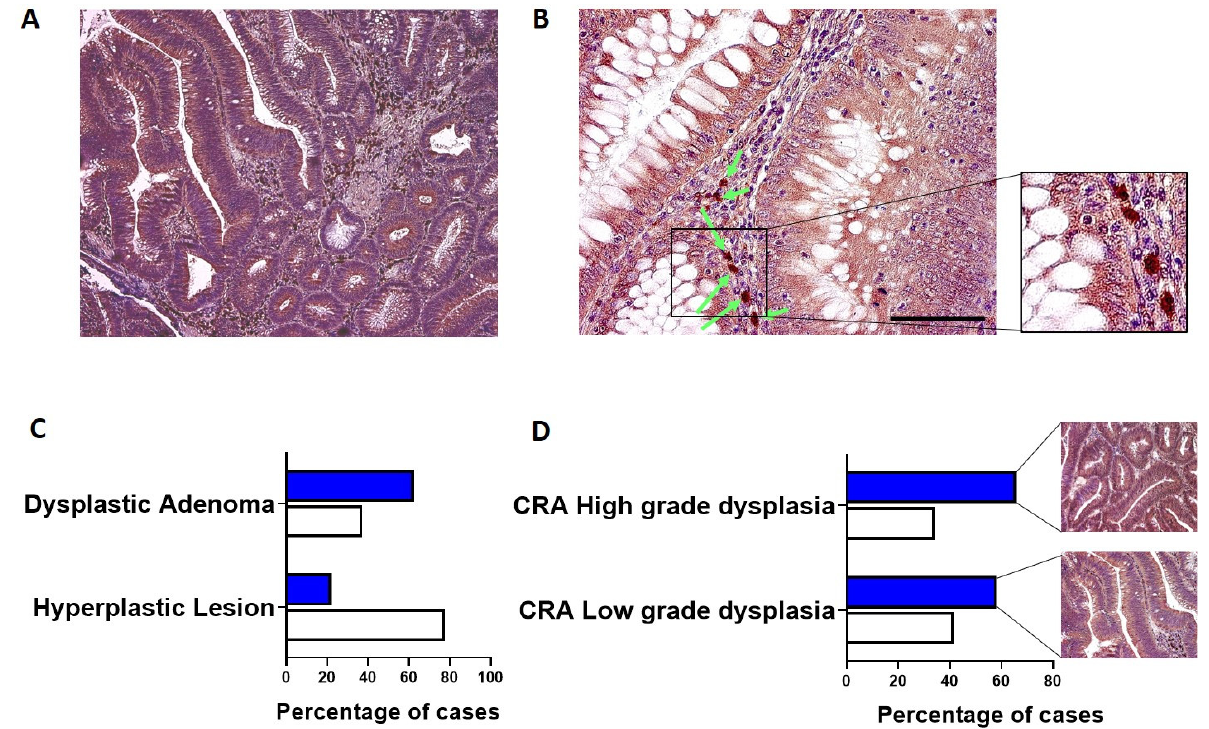
Figure 1. hERG1 potassium channel expression in CRA. ( A , B ) representative samples showing a high hERG1 expression in the epithelial cells as well as in plasma cells (see arrows in panel ( B ) and inset to panel ( B ). Scale bar: 100 µ m. ( C ) Histogram showing hERG1 expression according to the presence of dysplasia. White bars: hERG1 negative, Blue bars: hERG1 positive. ( D ) Histogram showing hERG1 expression according to the grade of dysplasia. White bars: hERG1 negative, Blue bars: hERG1 positive. Representative slides of the two groups are also